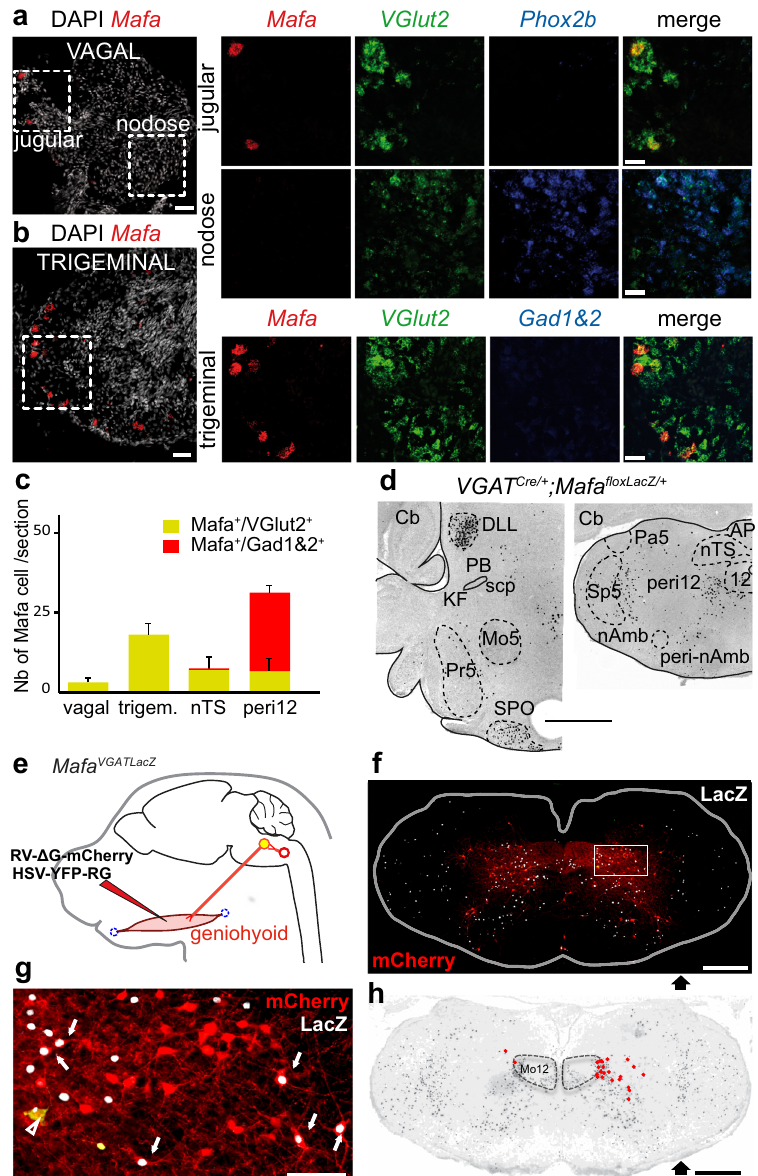
Fig. 4 Absence of Mafa inhibitory neurons in sensory and pontine respiratory structures and presence of Mafa inhibitory premotor neurons controlling the geniohyoid muscle. a Left, transverse sections of P0 wild type pups showing the vagal jugular and nodose ganglia stained for DAPI (white) and by RNAscope using a probe against Mafa (red). Right, top, close-up views from the jugular ganglion probing Mafa (red), VGlut2 (green), Phox2b (blue) and the merge. Right, bottom, close-up views from the nodose ganglion. b Transverse sections of the trigeminal ganglion stained for DAPI (white) and Mafa (red). Right, close up views of the inset in ( b ) probing Mafa (red) , VGlut2 (green) and Gad1 & Gad2 (blue). Note the absence of Mafa expression in the nodose ganglion, expression of Mafa in the jugular (sparse) and trigeminal ganglia restricted to VGlut2 -expressing excitatory neurons. c Summary of RNAscope probing for co- expression of Mafa/VGlut2 - and Mafa/Gad1&2 -expression in vagal (5 sections, n = 3 ganglia) and trigeminal (7 sections, n = 3 ganglia) ganglia, nucleus tractus solitarius (nTS, 8 sections, n = 2 pups) and peri12 (8 sections, n = 2 pups). Plots represent mean±sem. d Left, transverse hemi-section of the brainstem at pontine level of a VGAT Cre/ + ; Mafa FloxLacZ/ + P8 pup, showing absent Mafa + inhibitory neurons (black) in the PB/KF, Pr5 areas but their presence in the SPO and DLL. Right, representative transverse hemi-section of the brainstem at medullary level showing the presence of Mafa + inhibitory neurons in the peri12, peri- nAmb but their virtual absence in the Sp5, Pa5 and nTS ( n = 2 pups). e Monosynaptic tracing scheme showing unilateral injection of G-deleted Rabies viruses encoding mCherry and of a helper G- and YFP-encoding HSV virus into the geniohyoid muscle to transynaptically trace the position of premotor neurons. f Representative transverse section (from n = 4 VGAT cre/ + ; Mafa fl oxLacZ/ + pups) immunostained for β gal (white) in the caudal medulla showing mCherry + virally labeled premotor neurons (red) and rare (at this axial level) seeding mCherry + /YFP + geniohyoid motoneurons (yellow) in the accessory hypoglossal motor nucleus (arrowhead). g Close-up view of the inset in f showing that a fraction of mCherry + premotor neurons indicated by arrows are Mafa + (mCherry + / β gal + , white nuclear labeling). h 2D-reconstruction of the position of Mafa + geniohyoid premotor neurons (red dots) and Mafa + cells (gray dots) showing their location in the peri12 area. DLL dorsal nucleus of the lateral lemniscus, KF Kölliker-Fuse nucleus, PB parabrachial nuclei, Pa5 paratrigeminal nucleus, Pr5 principal sensory trigeminal nucleus, scp superior cerebellar peduncle, SPO superior paraolivary nucleus. Scale bars ( µ m): 100 ( a , b left, c ), 50 ( a , b right), 1000 ( d ), 500 ( f , h ), 100